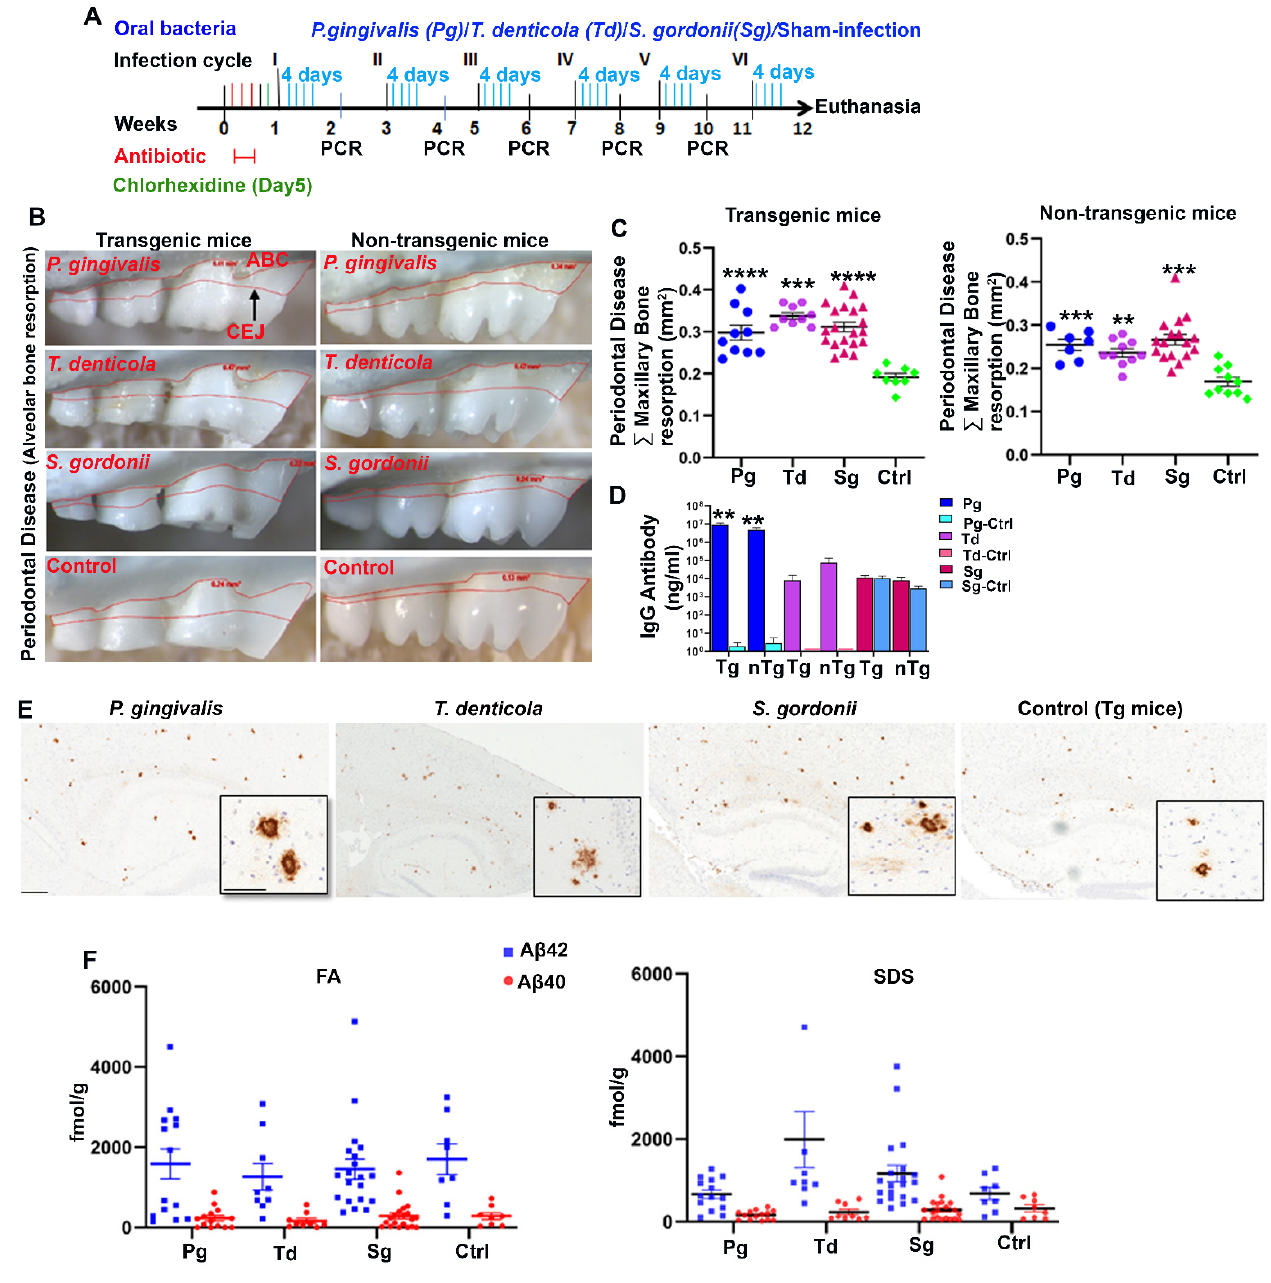
Figure 1. Gingival infection significantly induced alveolar bone resorption (ABR) but did not sig- nificantly affect A β levels in Tg mice. ( A ) Schematic diagram of the experiment design depicting the bacterial mono-infection (4 days a week every other week), antibiotic (3 days), chlorhexidine treatment (on day 5), gingival plaque sampling for colony PCR, and euthanasia. ( B ) Representative images showing horizontal ABR (maxilla palatal view) of Tg and nTg mice infected with P. gingivalis, T. denticola, S. gordonii, and sham-infected Tg and nTg mice with an area of ABR outlined from alveolar bone crest (ABC) to cementoenamel junction (CEJ). ( C ) Morphometric analysis of the total maxillary ABR in mice. Significant ABR was observed in bacterial-infected Tg and nTg mice compared to the sham-infected Tg and nTg mice (****, p < 0.0001; ***, Adjusted p value = 0.0004; **, Adjusted p value = 0.0019; Ordinary One-way ANOVA; Dunnett’s multiple comparison test). D Serum IgG antibody levels in Tg and nTg mice. Serum IgG antibody level was significantly increased in P. gingivalis-